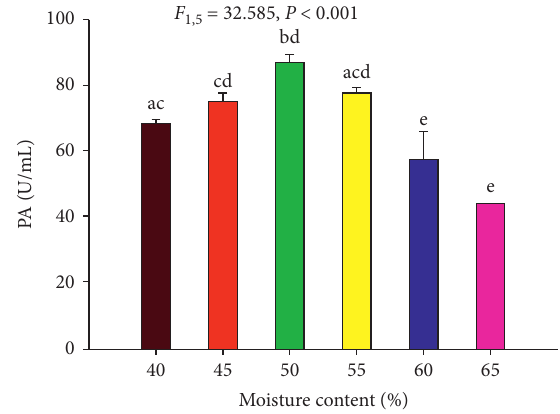
Figure 7: Effect of moisture content on acid protease production by the filamentous fungal isolate Z1BL1 in SSF. PA: protease activity. Different letters (a, b, c, d, e) designate significantly different means as determined by the SPSS test ( P < 0 . 001 ) ; wheat bran moistened with the salt solution; initial media pH 5; temperature 30 ° C.